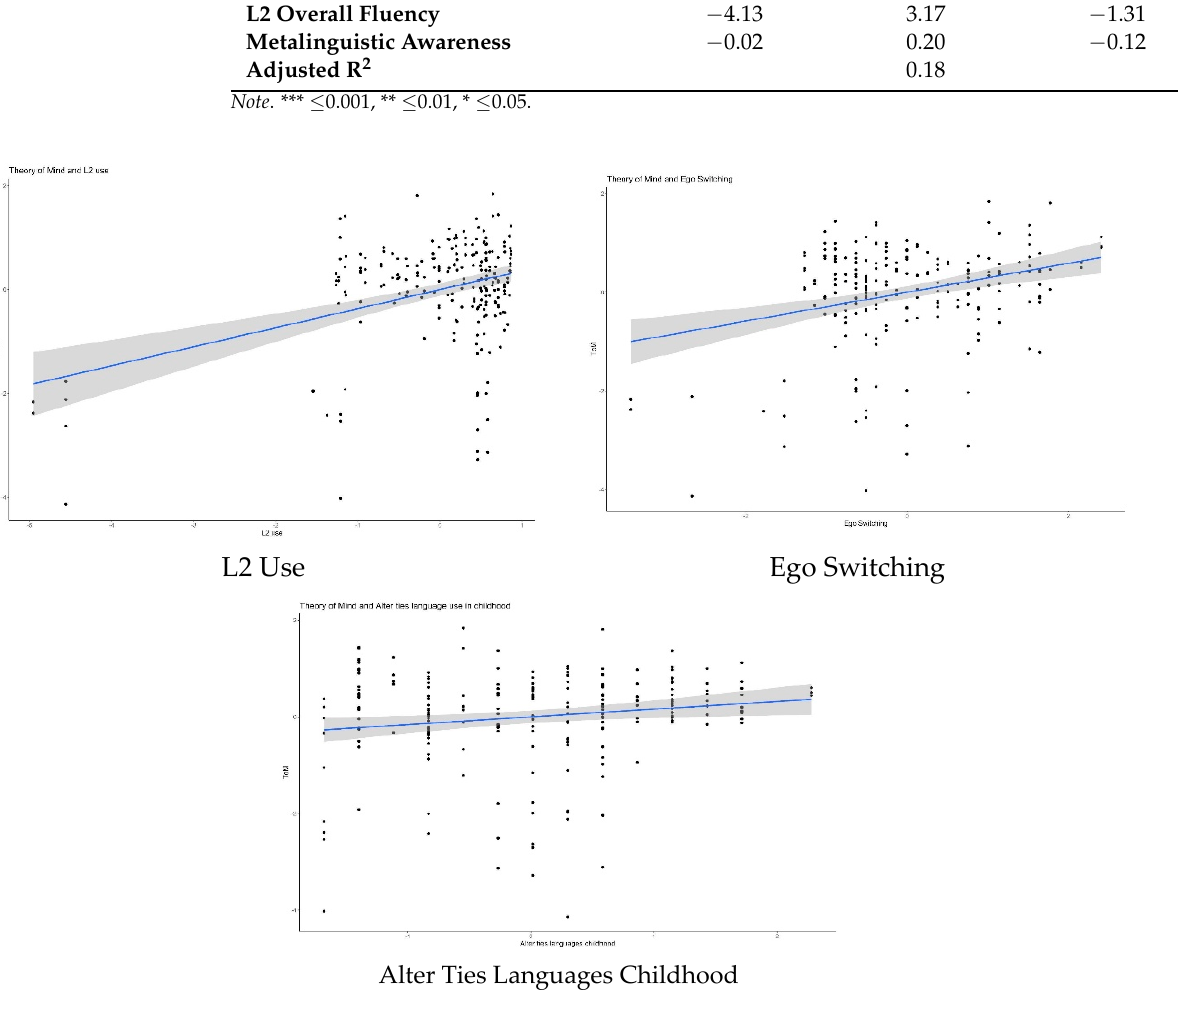
Figure 1. Significant effects of multiple regression. L2 use (upper left), ego switching (upper right), and alter ties languages in childhood (bottom) as predictors of ToM.